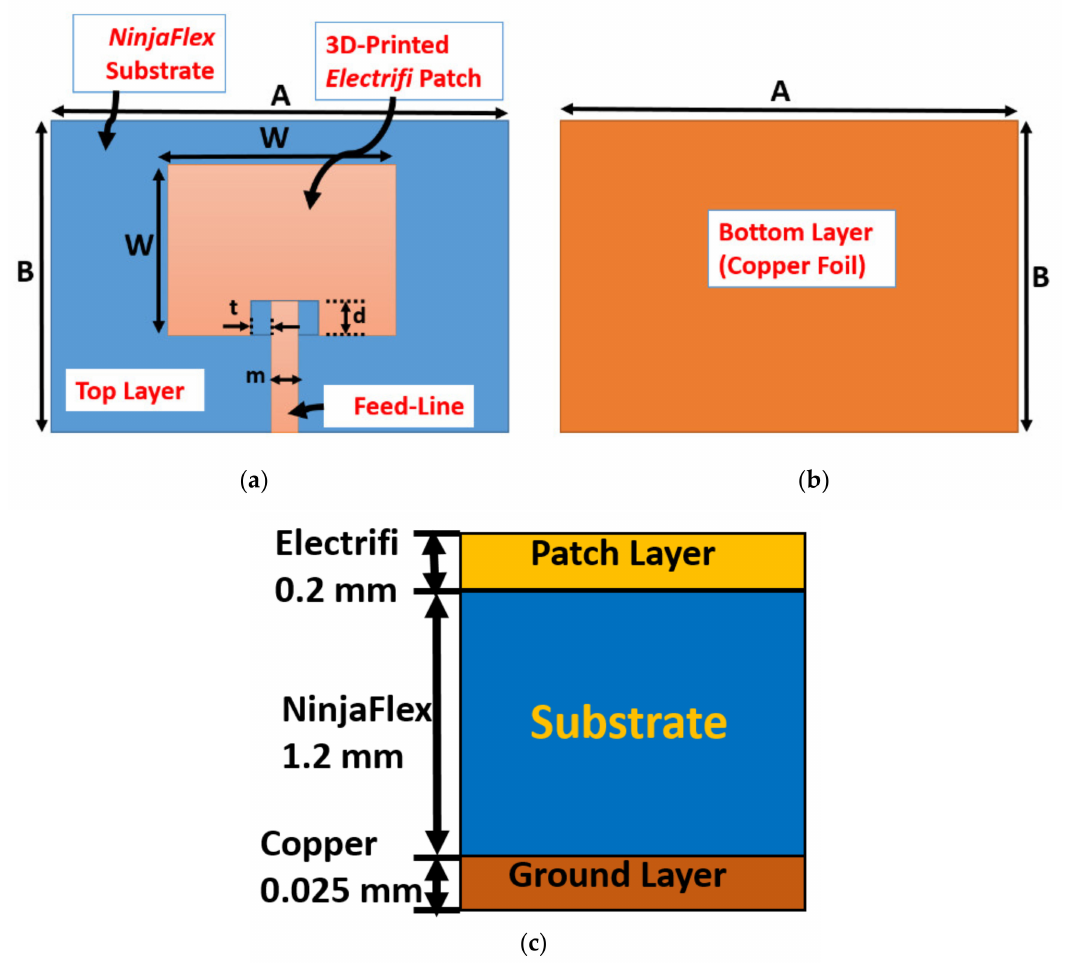
Figure 6. Geometry of the microstrip patch antenna made of Electrifi on NinjaFlex substrate backed with adhesive copper foil, ( a ) top view and ( b ) bottom view; ( c ) layer map of the 3D-printed Electrifi patch. Structure characteristics: A = 65.55, B = 55.5, W = 37, d = 7, t = 1, and m = 3, all in